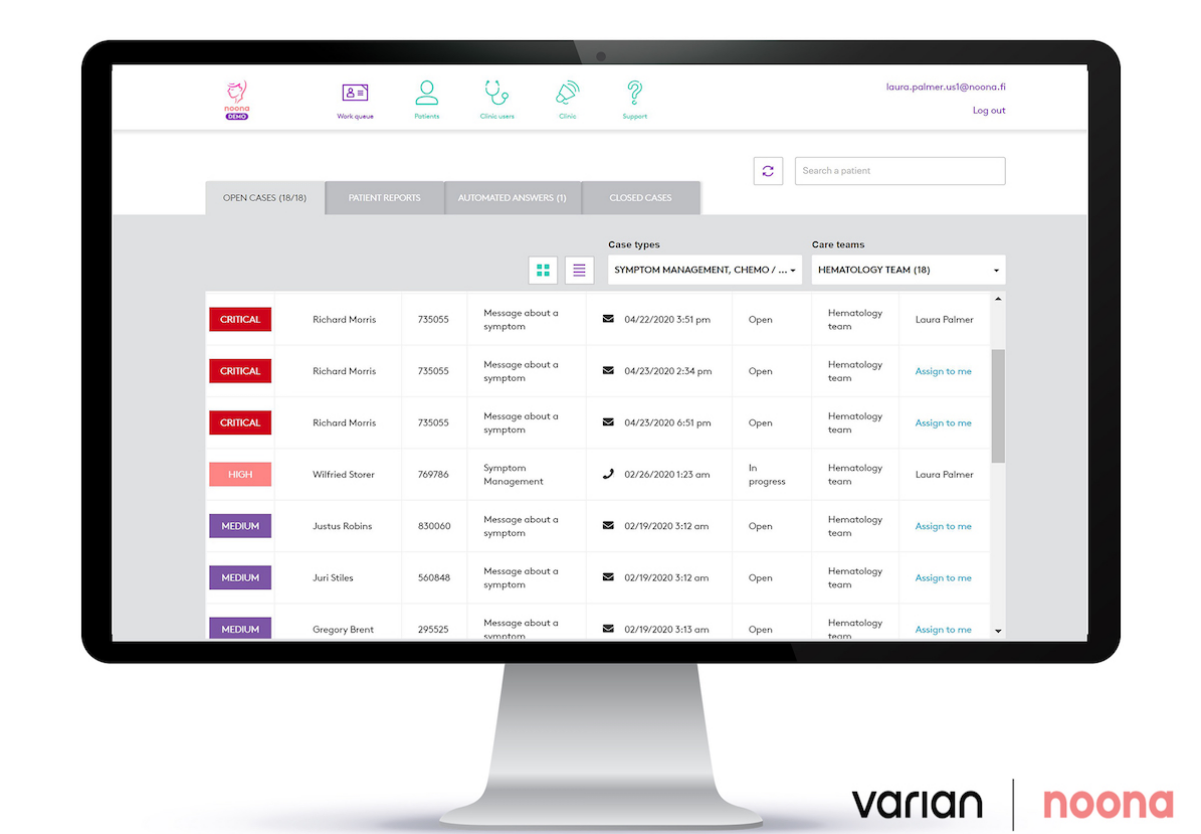
Figure 2. Noona interface for the